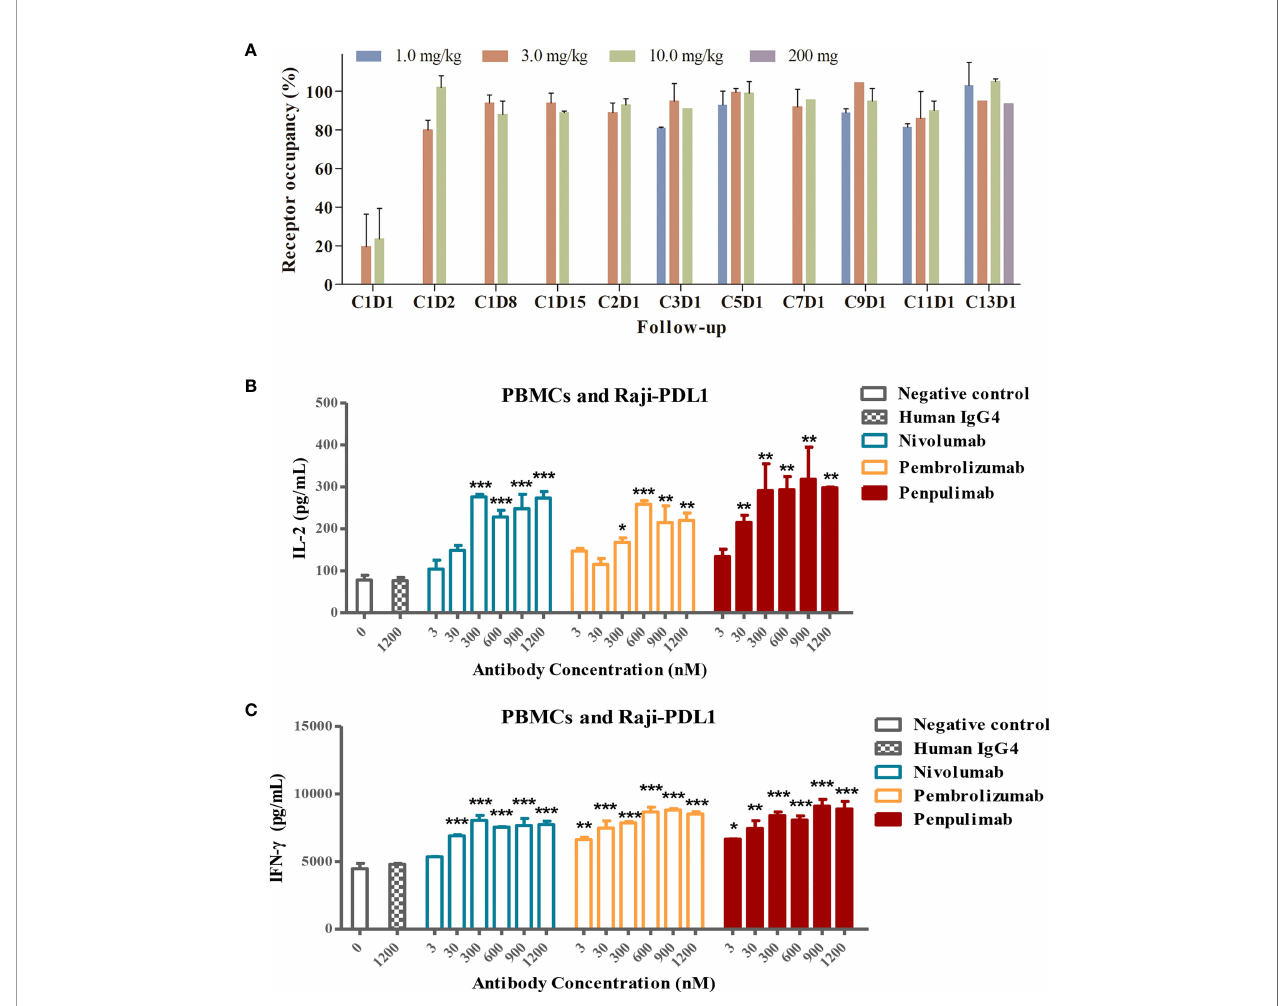
FIGURE 3 | (A) PD-L1 target occupancy following intravenous administration of 1.0, 3.0 or 10.0 mg/kg penpulimab once every two weeks (Q2W) in the dose escalation study or 200 mg penpulimab Q2W in the expansion study, with 28 days per cycle. Post-infusion blood samples were collected at day 1, 2, 8, and 15 of cycle 1, and day 1 of cycle 2, 3, 5, 7, 9, 11, and 13, respectively, as indicated on the x -axis. C: cycle; D: day. Penpulimab potentiates T cell activation via PD1/PDL1 blockade. Raji-PD-L1 cells overexpressing PD-L1 were co-cultured with peripheral blood mononuclear cells (PBMCs) from a normal subject, and the production of IL-2 (B) and IFN- g (C) was examined by ELISA. Data are shown as mean ± SEM for n = 2, and analyzed using one-way ANOVA . * P <0.05, ** P <0.01 and *** P <0.001 vs. isotype